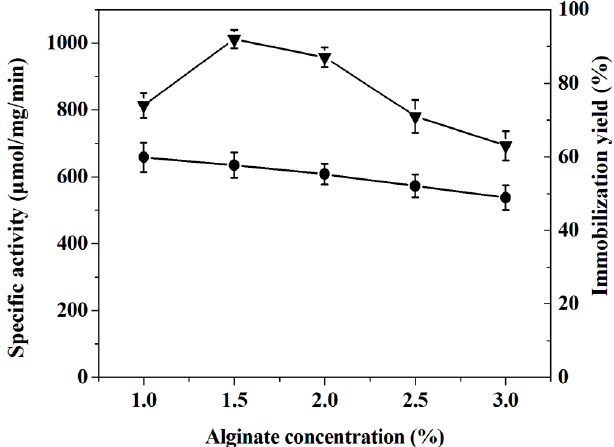
Figure 2. The effect of alginate concentration on speci fi c activity ( ● ) and immobilization yield ( ▼ ) of laccase entrapped by protocol I.